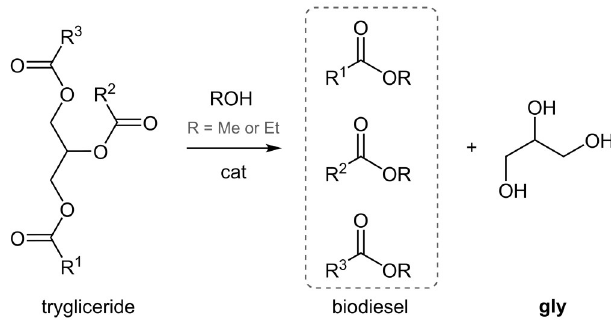
Figure 1. Biodiesel production through transesterification.